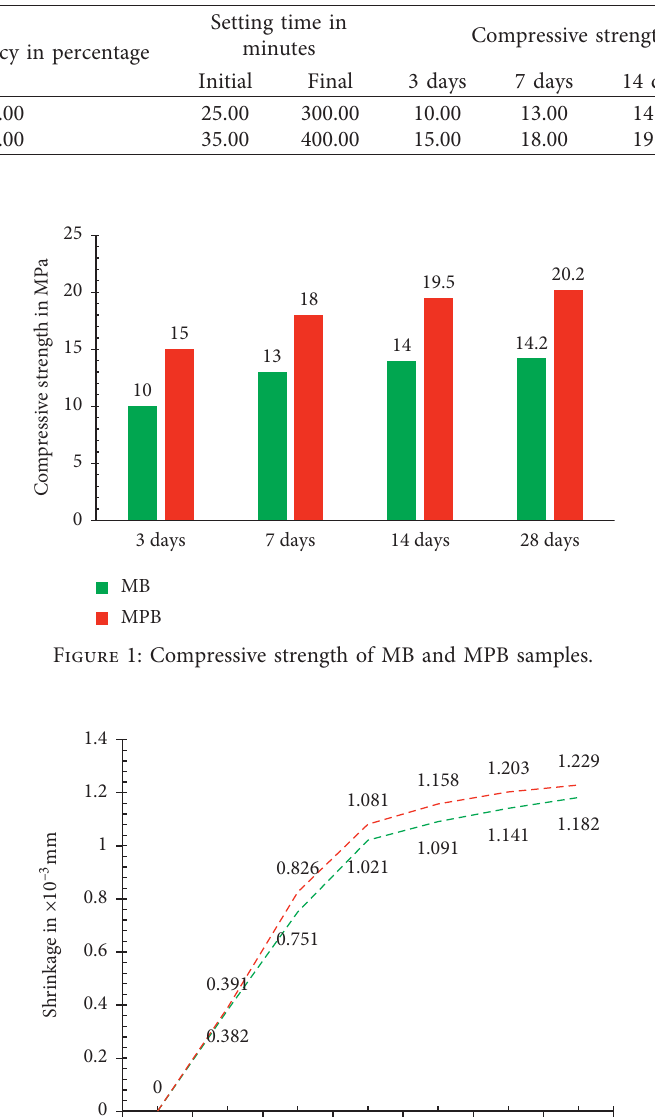
Table 3: Test results on consistency, setting time, and strength